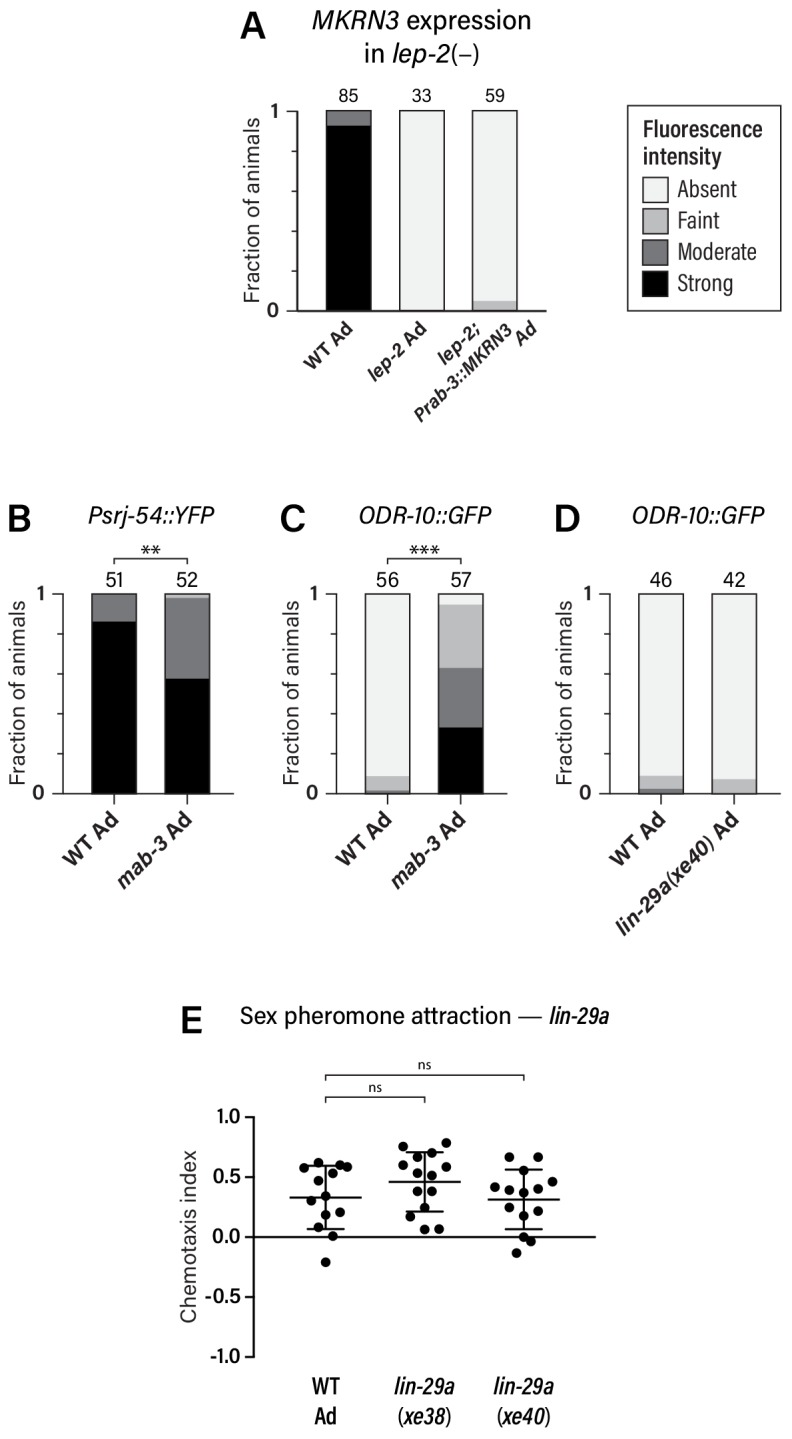
Genetic control of male sexual differentiation and behavior.(A) MKRN3 overexpression in the nervous system of lep-2 mutants. Bars indicate distributions of the intensity of Psrj-54::YFP expression. Non-transgenic siblings were used as WT controls. Numbers above each bar indicate numbers of animals scored. (B–D) Expression of Psrj-54::YFP (B) and ODR-10::GFP (C,D) in mab-3 (B–C) and lin-29a (D) mutants. Numbers indicate number of animals scored. Asterisks indicate statistical comparisons between WT and mutant animals. (E) Attraction to ascaroside pheromones using a quadrant-style assay. Each point represents the chemotaxis index calculated from one assay (ten animals). Asterisks indicate the significance of the indicated comparisons.10.7554/eLife.43660.014Figure 4—figure supplement 1—source data 1.Source data for Figure 4—figure supplement 1.